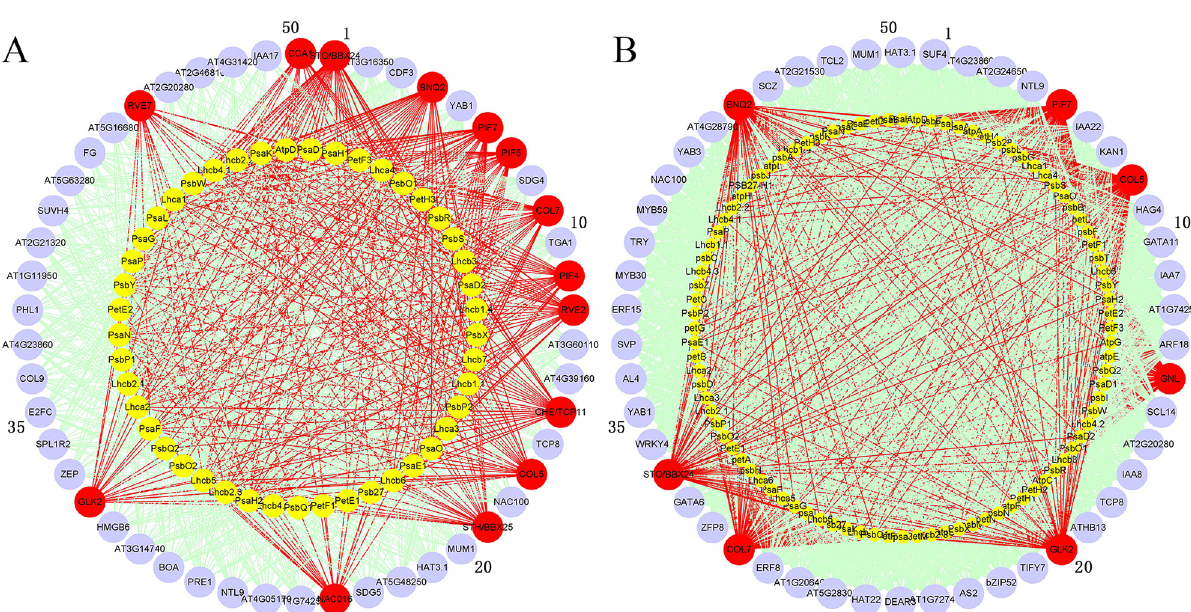
Figure 7. Gene regulatory networks produced by triple-gene mutual interaction (TGMI) ( A ) and sparse partial least squares (SPLS) ( B ) for Arabidopsis thaliana light reaction pathway using the RNA-seq data generated from leaf tissues. The yellow nodes represent light reaction pathway genes. All other nodes are the top 50 transcription factors that have the highest connectivity to pathway genes regardless of their colors. The red nodes represent known positive regulatory genes that affect light reaction pathway while the red edges are to show the connections of a true positive known pathway regulator with pathway